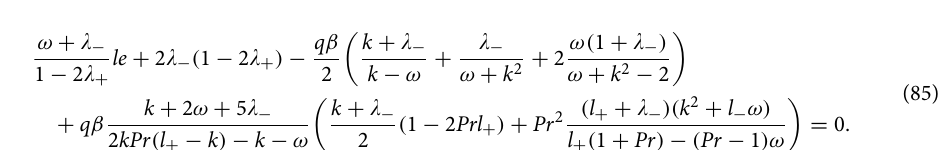
0 (thin lines) and 3/4 (thick =